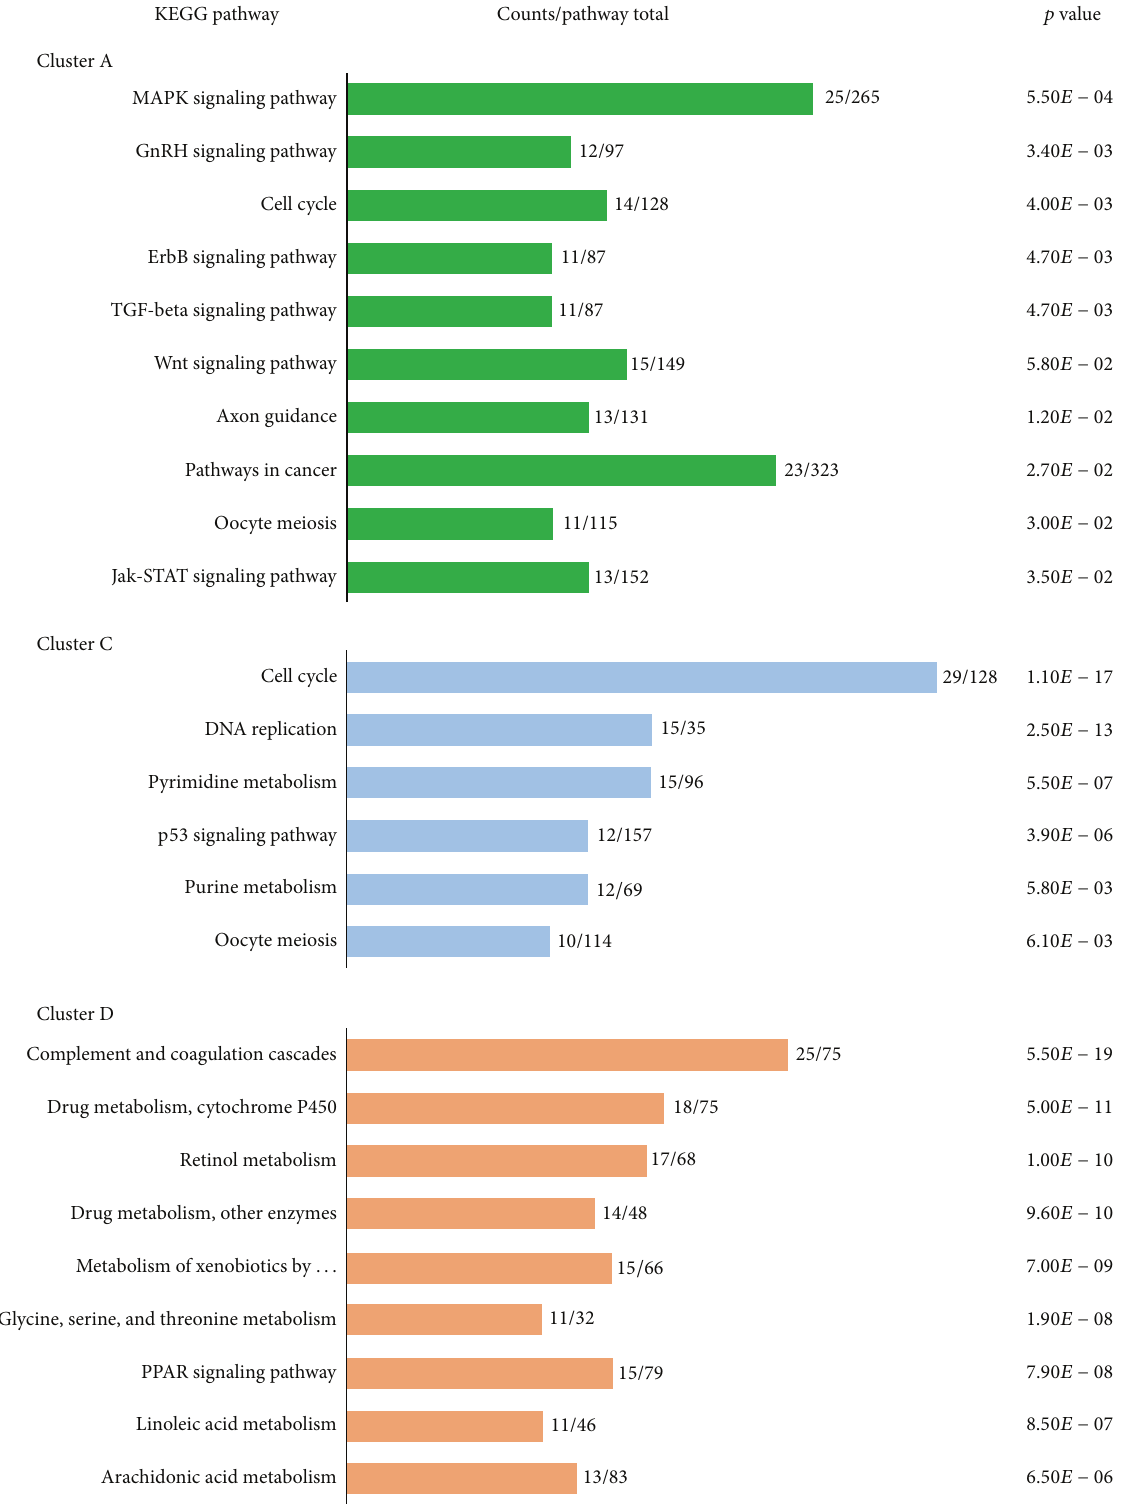
Figure 3: Probe set clusters A, C, and D contain pathways that are overrepresented in LPCs and liver tissue. Clusters A and C contain probe sets that are upregulated in liver progenitor cells (LPCs) and cluster D contains those that are upregulated in developed liver whilst being low in LPCs. The Database for Annotation, Visualization and Integrated Discovery online tool was used to identify overrepresented pathways ( 𝑝 < 0.05 ) within each of these clusters. Pathways are displayed together with the number of genes from the cluster list (counts), the total that belongs to each pathway (pathway total) and corresponding 𝑝